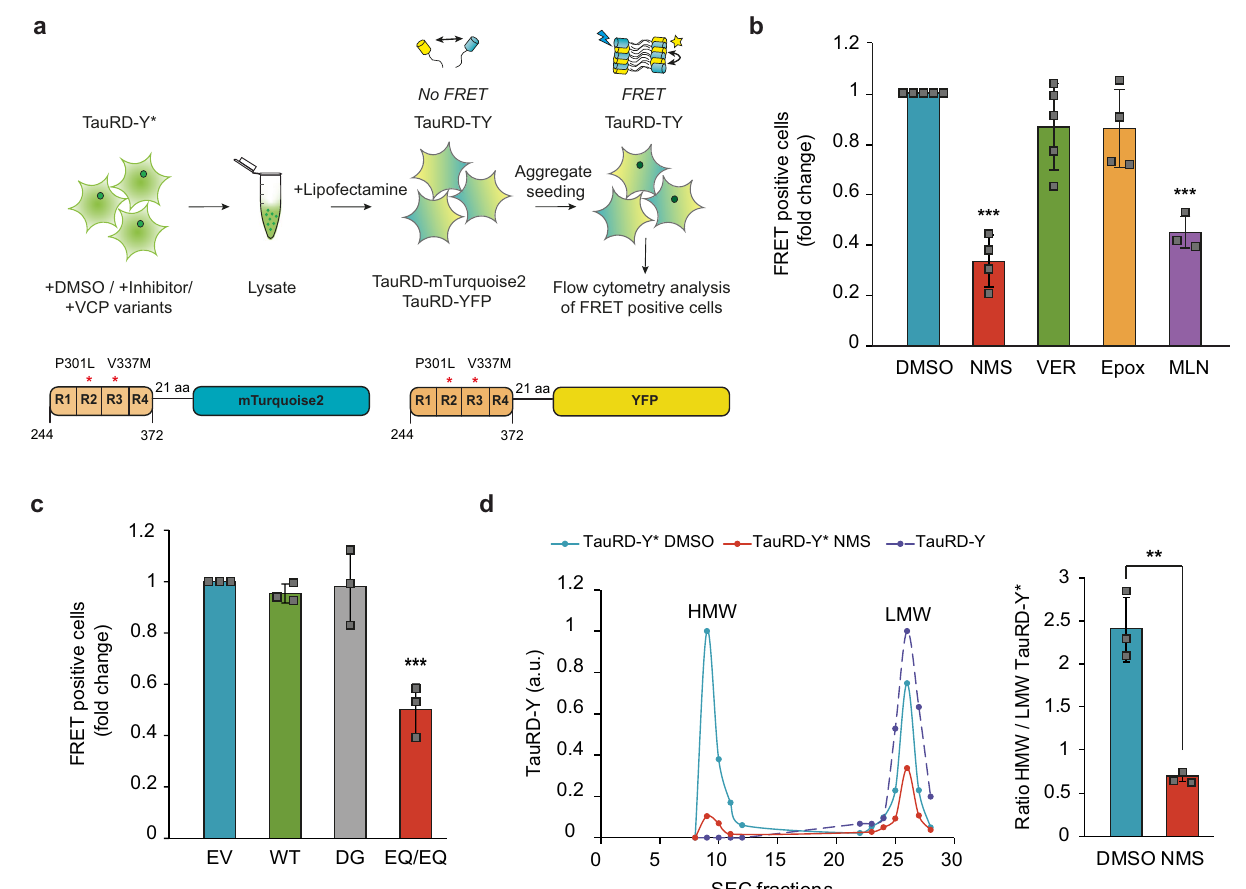
Fig. 6 | VCP-mediated disaggregation generates seeding-competent TauRD-Y species. a Experimental scheme to assess the effects of inhibitors of VCP, Hsp70, proteasome,andubiquitylationonthelevelofTauRD-YaggregateseedsinTauRD- Y*cells. b Flow cytometryanalysisof aggregateseeding in TauRD-TYreportercells after the addition of lysates from TauRD-Y* cells treated with NMS (VCP inhibitor), VER (Hsp70 inhibitor), Epox (proteasome inhibitor) and MLN (ubiquitylation inhi- bitor). Fold changes with respect to DMSO-treated cells are shown. Mean±s.d.; NMS and Epox n =4, VER n =5, MLN n =3; *** p <0.001 (DMSO vs NMS, p =8.69×10 − 7 ;DMSO vsMLN, p =4.2×10 − 5 ) fromone-way ANOVAwithTukey post hoctest. c FlowcytometryanalysisofaggregateseedinginTauRD-TYreportercells after addition of lysates from TauRD-Y* cells transfected with empty vector (EV),